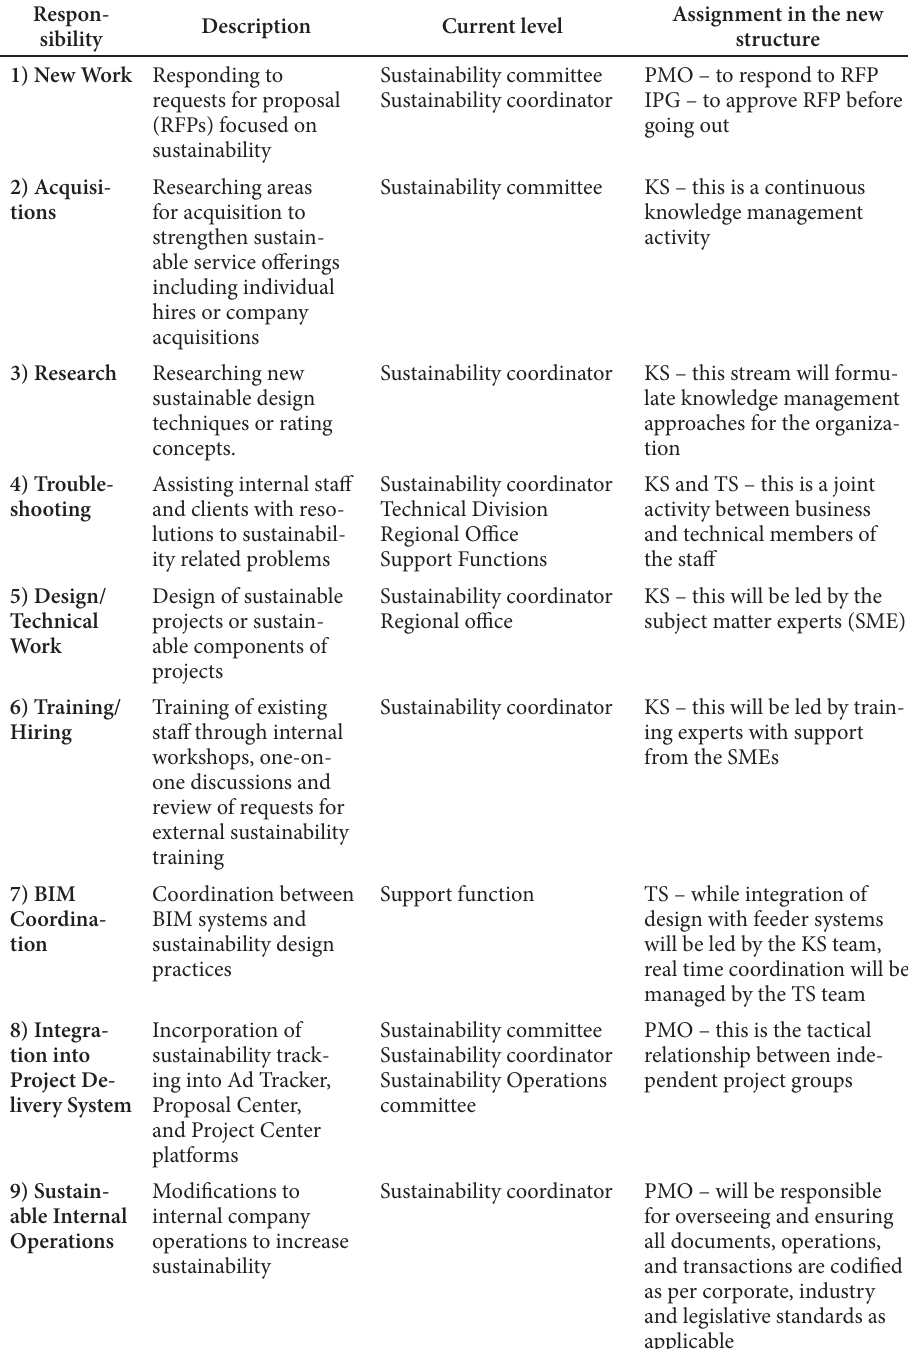
Table 4. Assignment of responsibilities within new governance structure Respon­